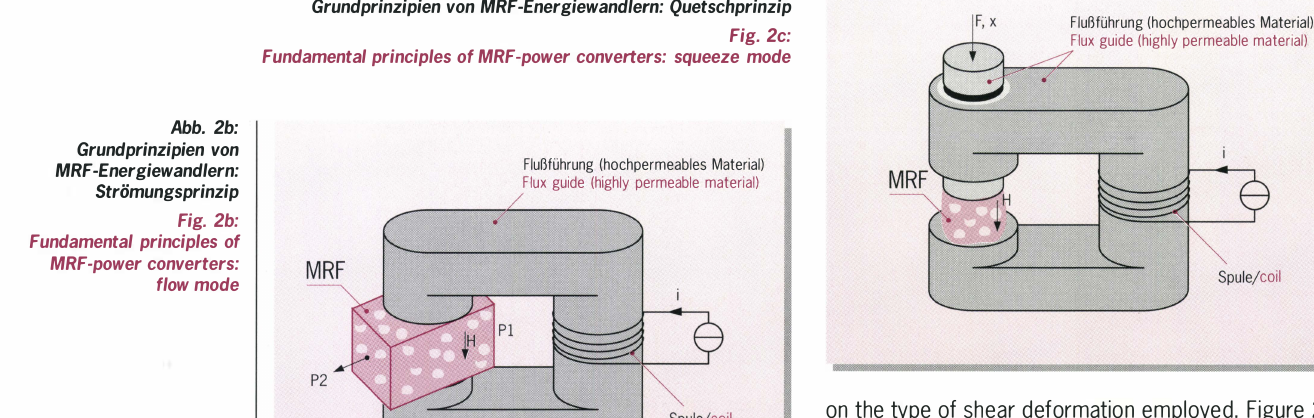
Fundamental principles of MRF-power converters: squeeze